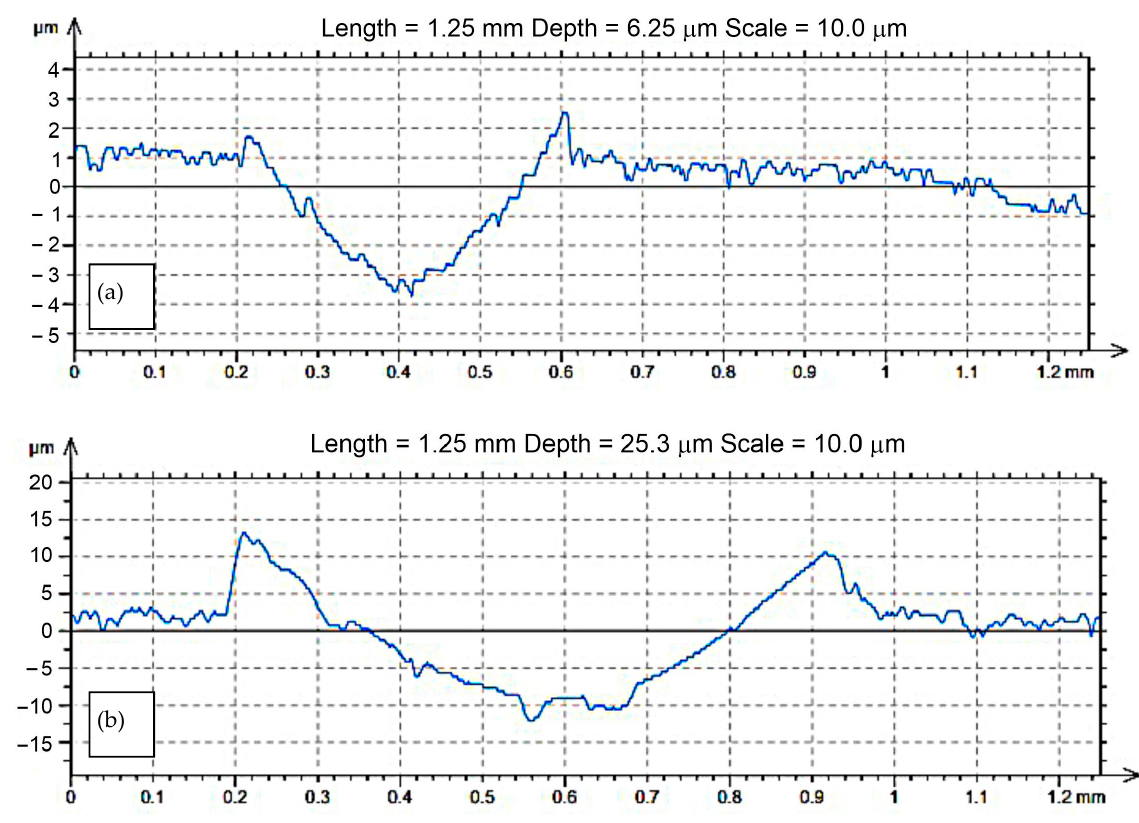
Figure 4. Transverse section of the scratch groove profile in the CuNi 2 Si alloy sample with indenter from Al 2 O 3 ; ( a ) alloy supersaturated and aged at the temperature of 600 °C, ( b ) 650 °C for 60 min.